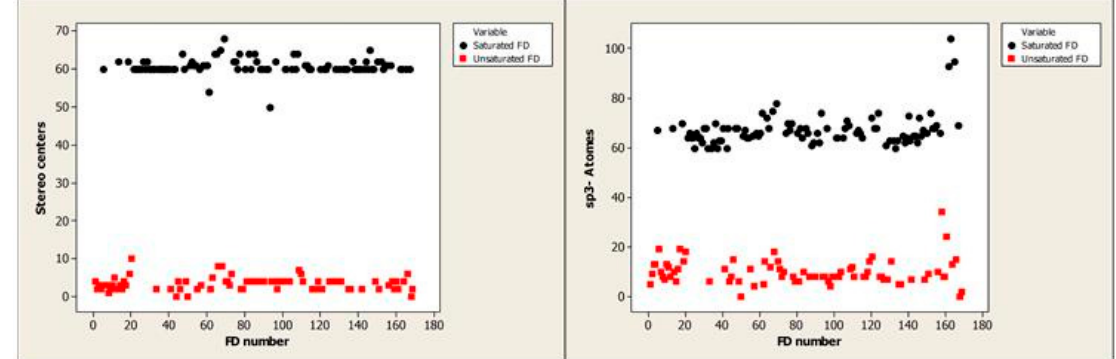
Figure 9. The distribution of saturated and unsaturated FDs depending on the stereo center and sp3-atoms descriptors.